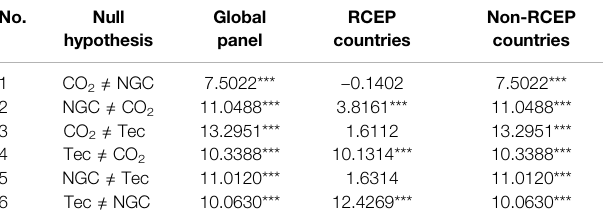
TABLE 7 | Results of the D-H panel causality